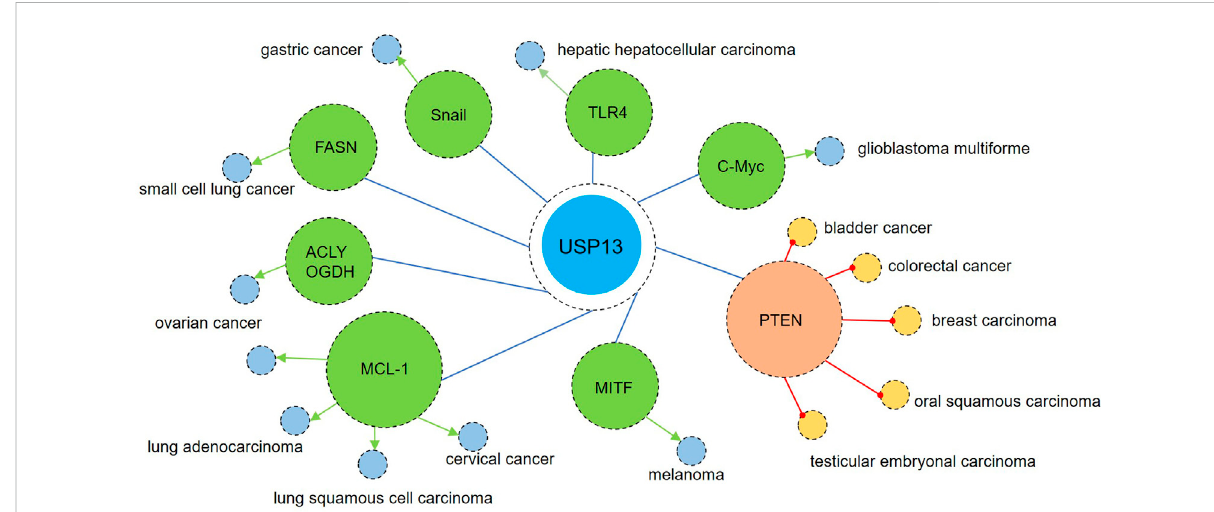
FIGURE 6 USP13 in cancers. On one hand, USP13 is upregulated in many types of tumors such as lung adenocarcinoma, lung squamous cell carcinoma, small cell lung cancer, ovarian cancer, cervical cancer, hepatic hepatocellular carcinoma, glioblastoma multiforme, melanoma, and gastric cancer. Enhanced USP13 promotes the proliferation, migration, and invasion of tumor cells by upregulating multiple oncogenic factors including MCL-1, c-Myc,TLR4,MITF,andSnail.Besides,USP13alsoadvancedcancermetabolism via modulationofkeyenzymesACLY,OGDH,andFASN.Onthe other hand, downregulation of USP13 is observed in some kinds of cancers including breast carcinomas, bladder cancer, oral squamous carcinoma, colorectal cancer, and testicular embryonal carcinoma. Overexpression of USP13 showed anti-tumor effects via upregulation of the tumor suppressor PETN. Blue circle indicates that USP13 can be upregulated in these cancers supported by most studies; Yellow circle represents that USP13 can be downregulated in these cancers suggested by most reports. Green arrow indicates promotion; Red circular arrow represents